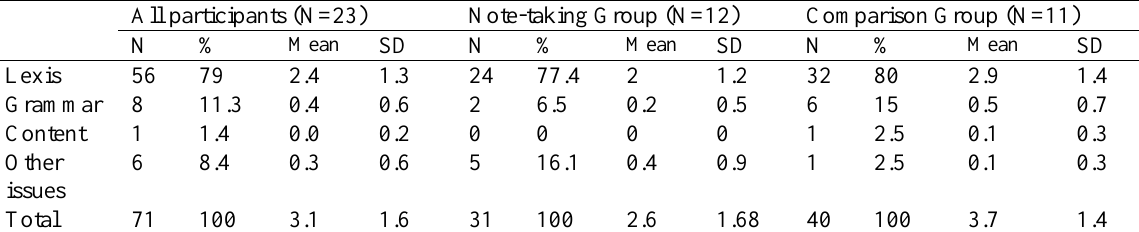
Frequencies and Ratios of Problems Recognized in the Initial Written Output Task All participants (N=23) Note-taking Group (N=12) Comparison Group